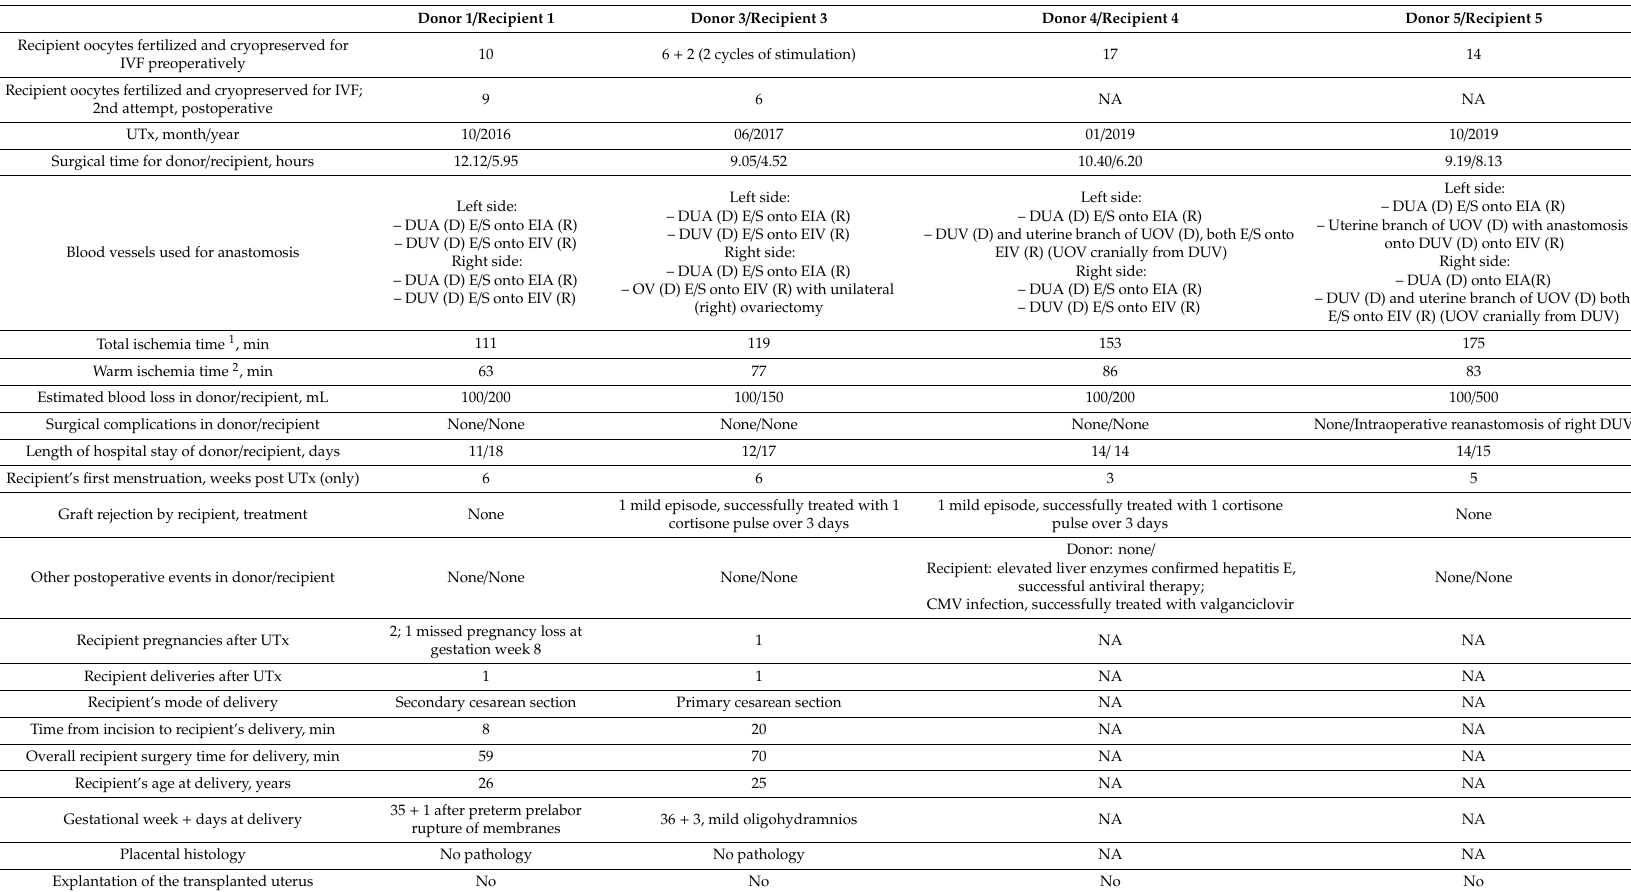
Table 2. Uterus transplantation: pre-, intra-, and postoperative recipient and donor clinical characteristics.